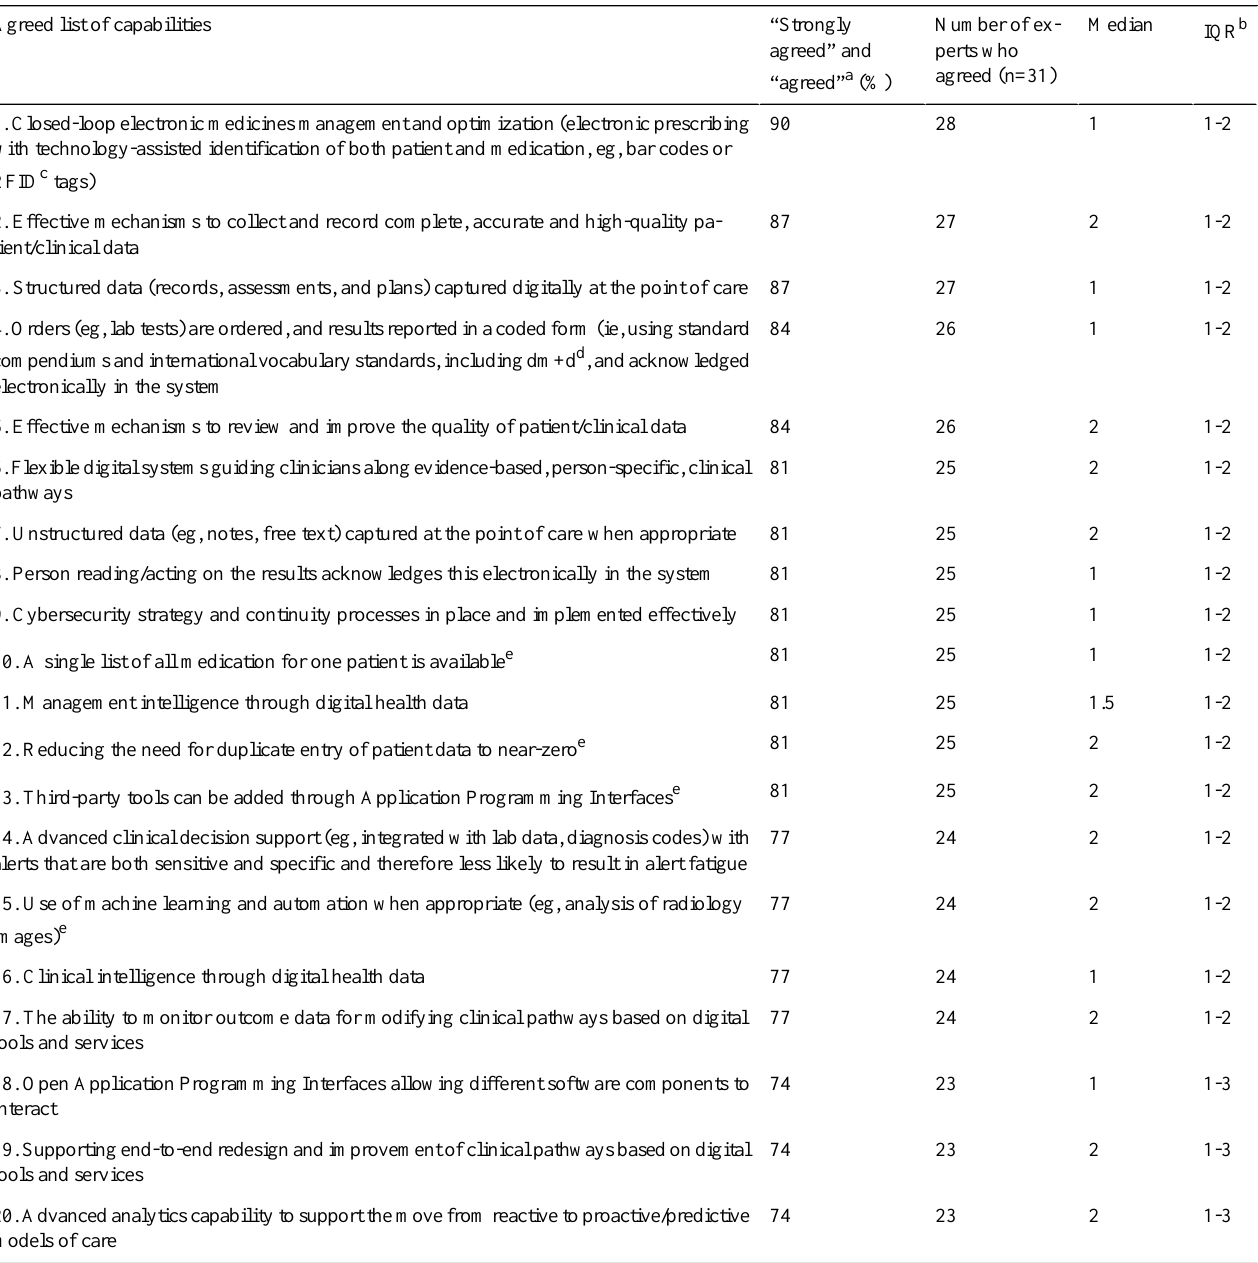
Table 2. Technological capabilities within